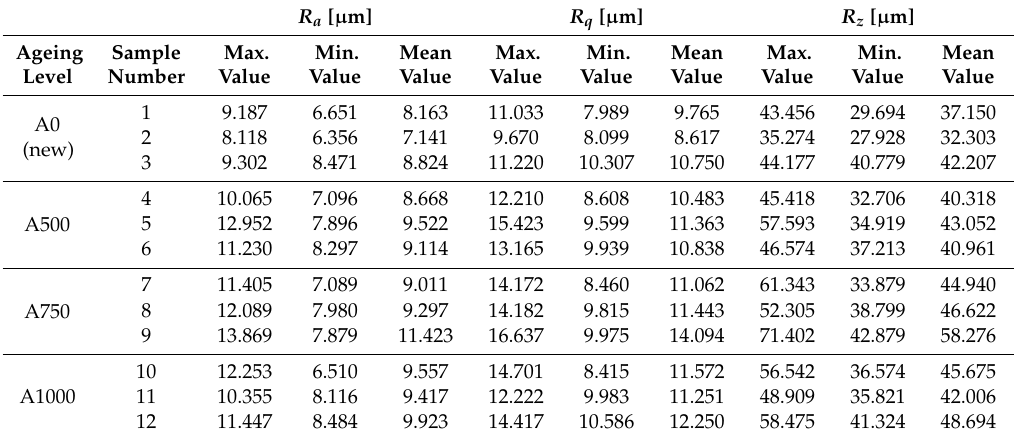
Table 3. T-type S-line connectors. Results of the surface roughness measurements.